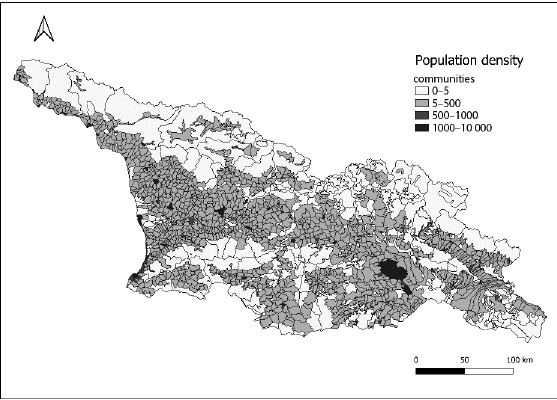
Figure 8. Population density by communities